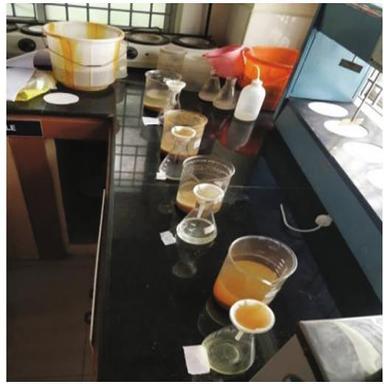
Process of Separating Binder and Aggregate.